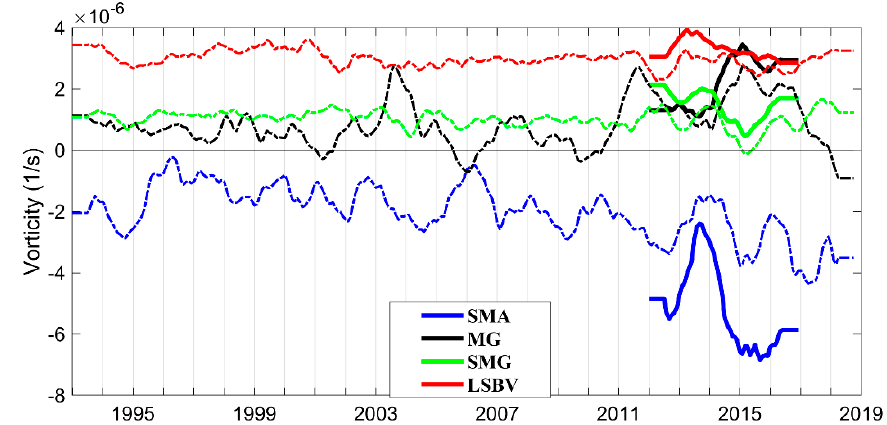
Figure 11. Time series of the spatially averaged, low pass filtered (13 month) vorticity field over the regions of MG, SMA, SMG, and LSBV. Dashed-dotted lines refer the vorticity field derived from the AGV. The continuous lines are related to the vorticity field derived from optimal currents from 2012 to 2016.